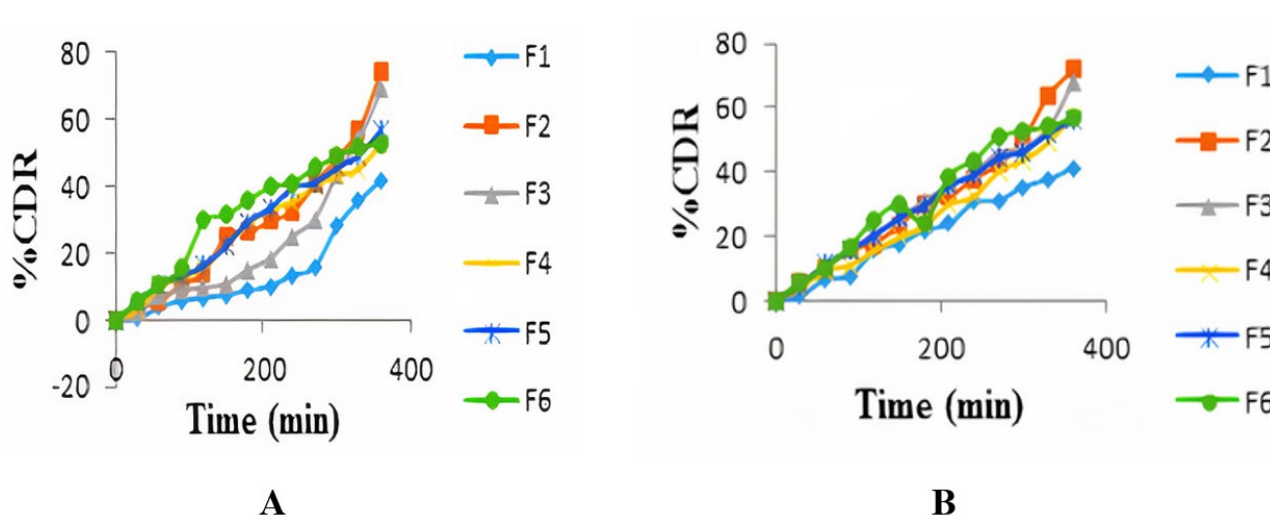
TABLE III - Kinetic analysis of in vitro drug release data of OFL and DX